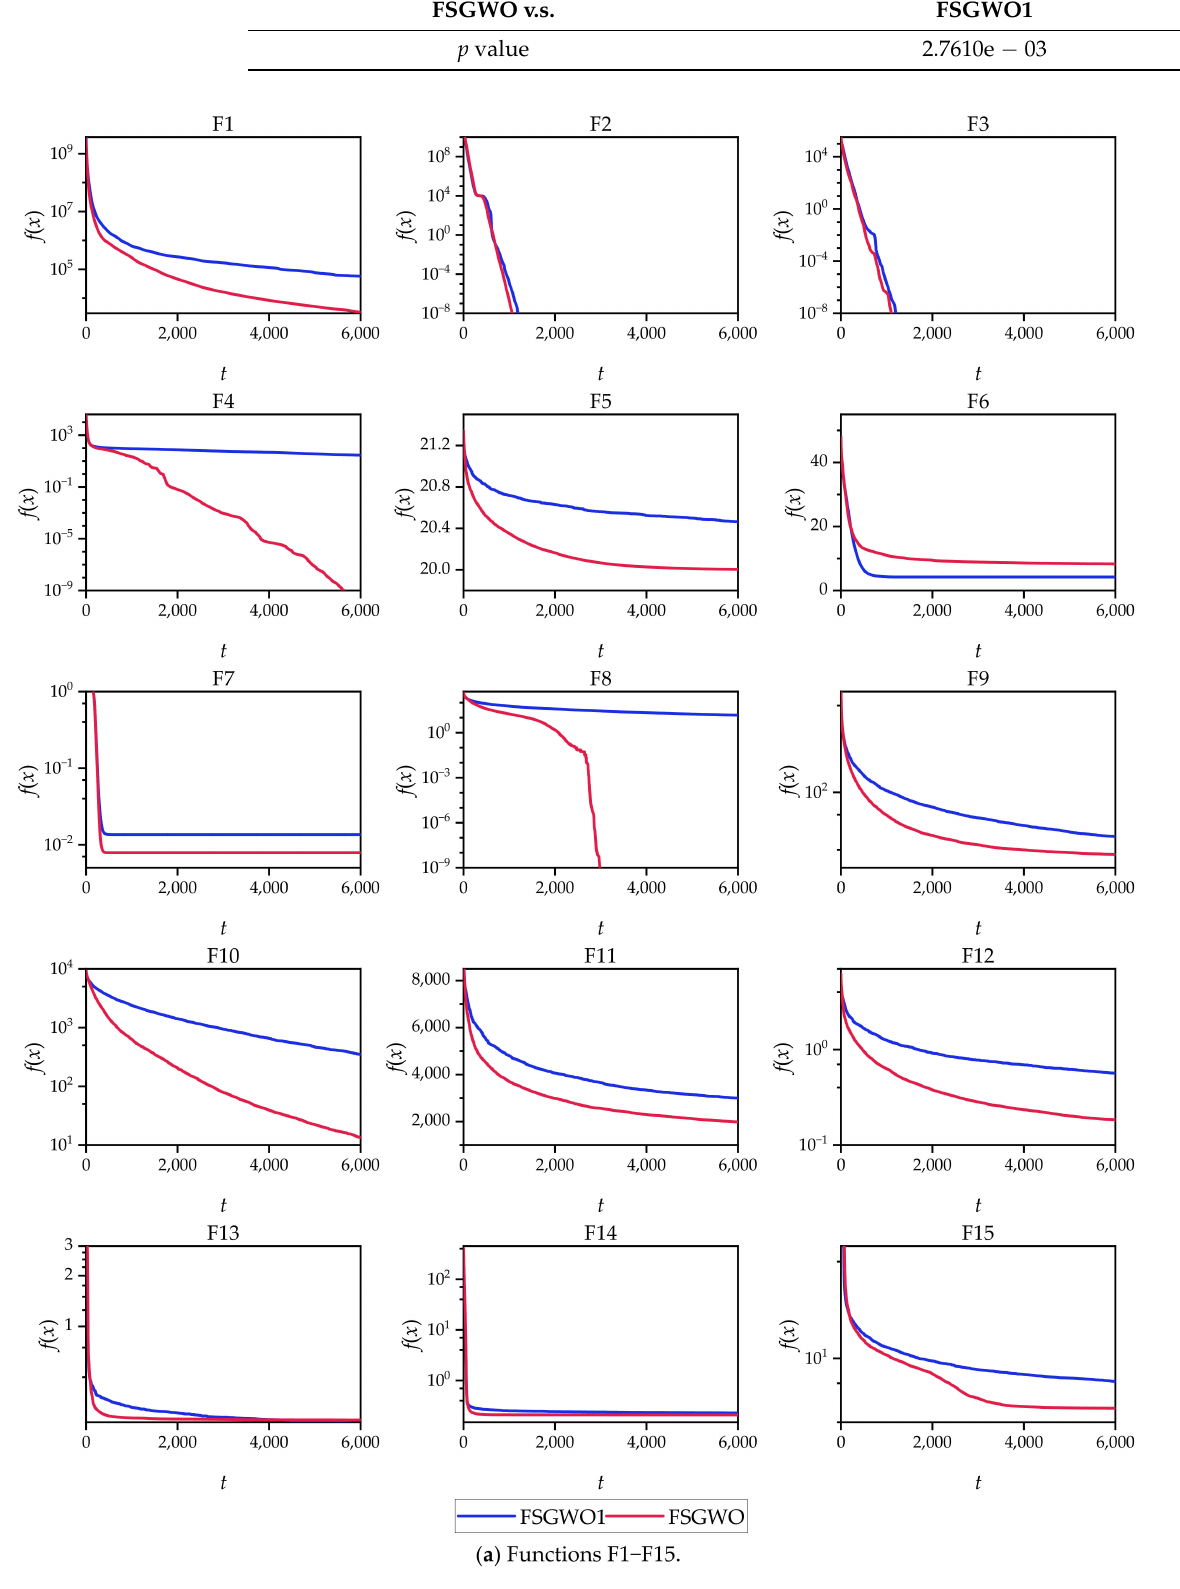
Table 9. Results of the Wilcoxon test for the mean values of Table 8.